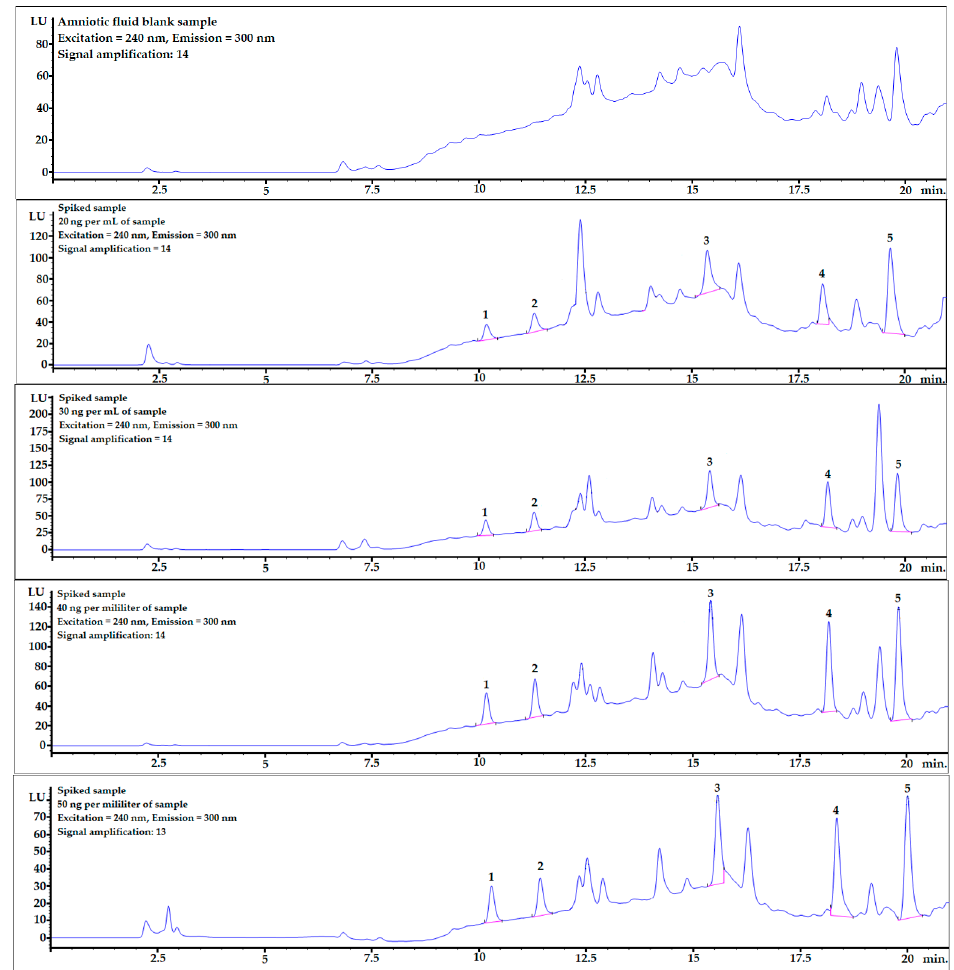
Figure 2. Examples of chromatograms obtained during recovery studies for each spiking level: 0 (averaged blank sample), 20, 30, 40, and 50 ng per mL of sample (from top to bottom). 1—BPF, 2—BPE, 3—BPAF, 4—BADGE · 2HCl, 5—BPP.